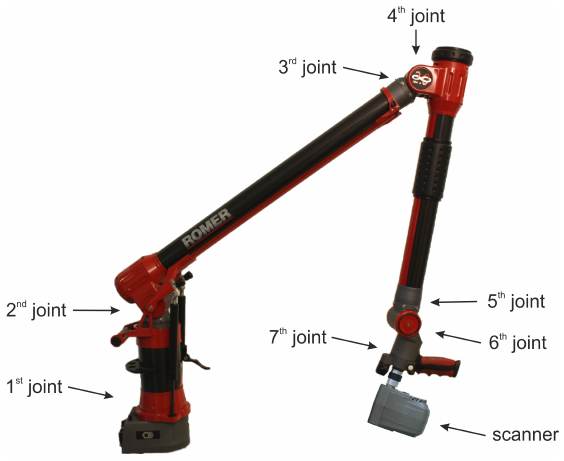
Figure 1. ROMER Infinite 2.0 measuring arm combined with a Perceptron ScanWorks-V5 laser